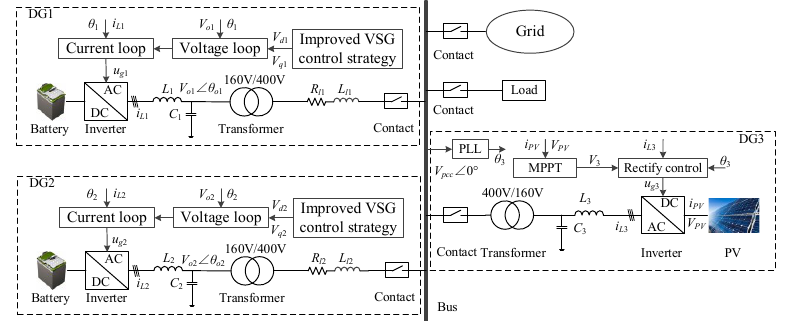
Figure 3. Connection model of